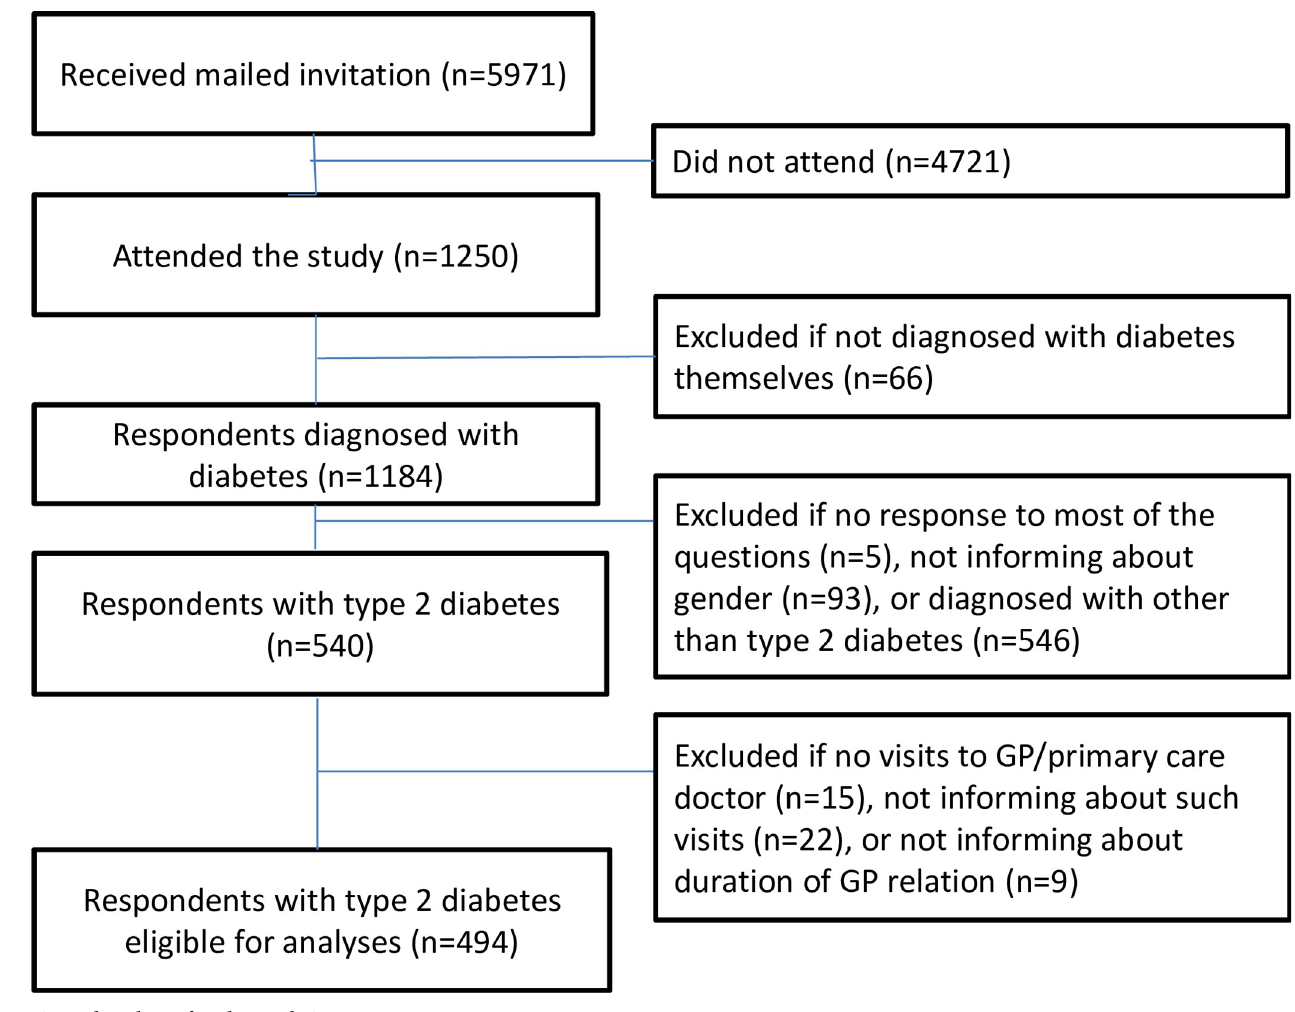
Fig 1. Flow chart of study population.